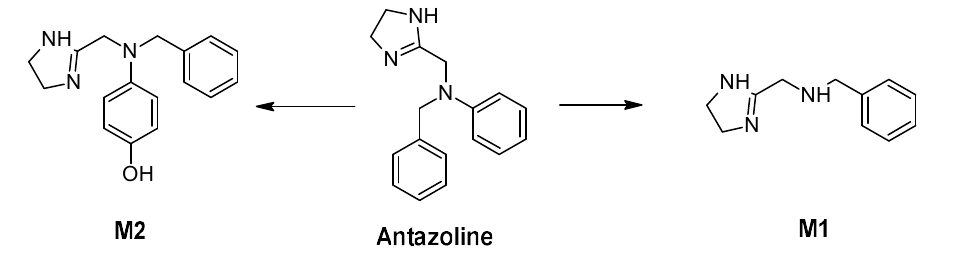
Figure 5. The main pathways of antazoline metabolism. Table 3. Simcyp input parameters for final antazoline PBPK model.